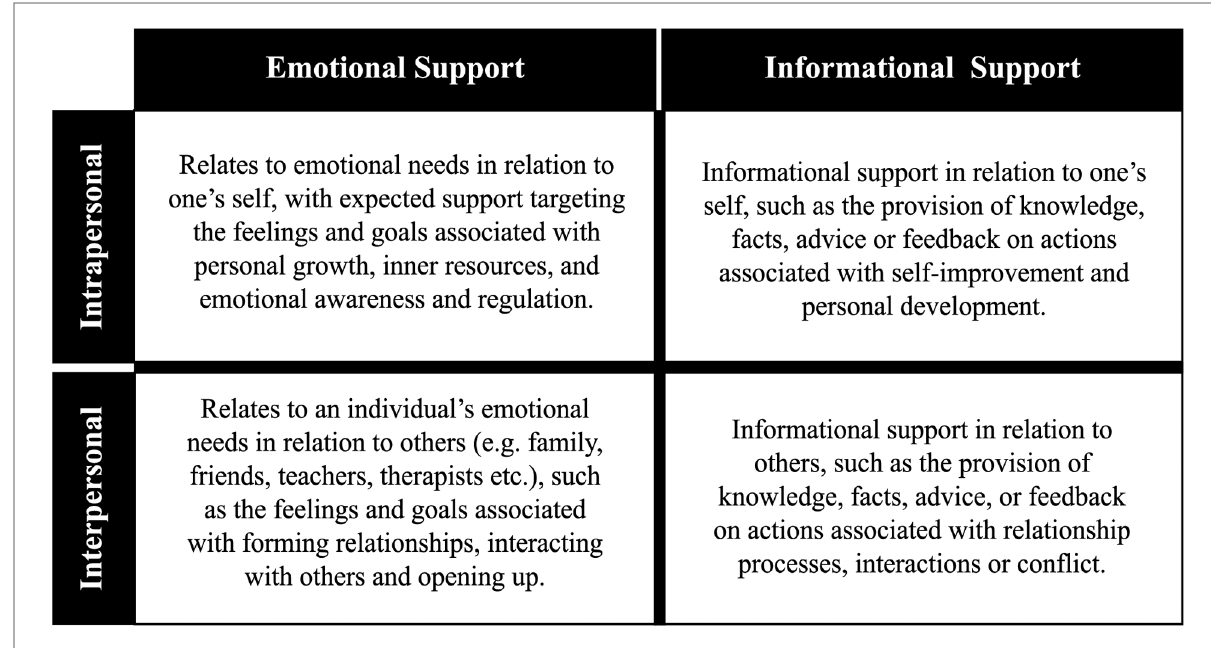
FIGURE 2 Kooth high-level domain of support (processes), “ wants ” and “ needs ” from children and young people accessing a digital mental health support service